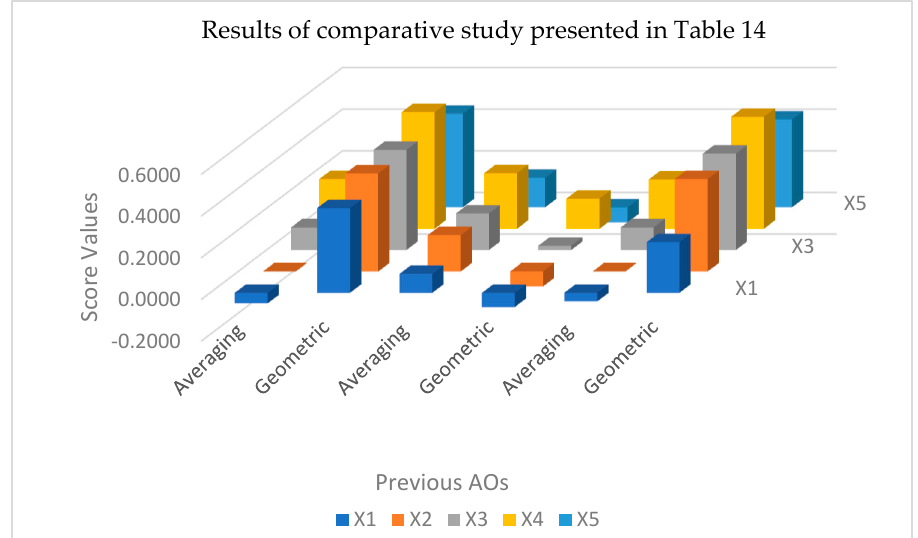
Figure 3. Score values using Khan et al. [23], Jana et al. [49] and Darko and Liang [8]